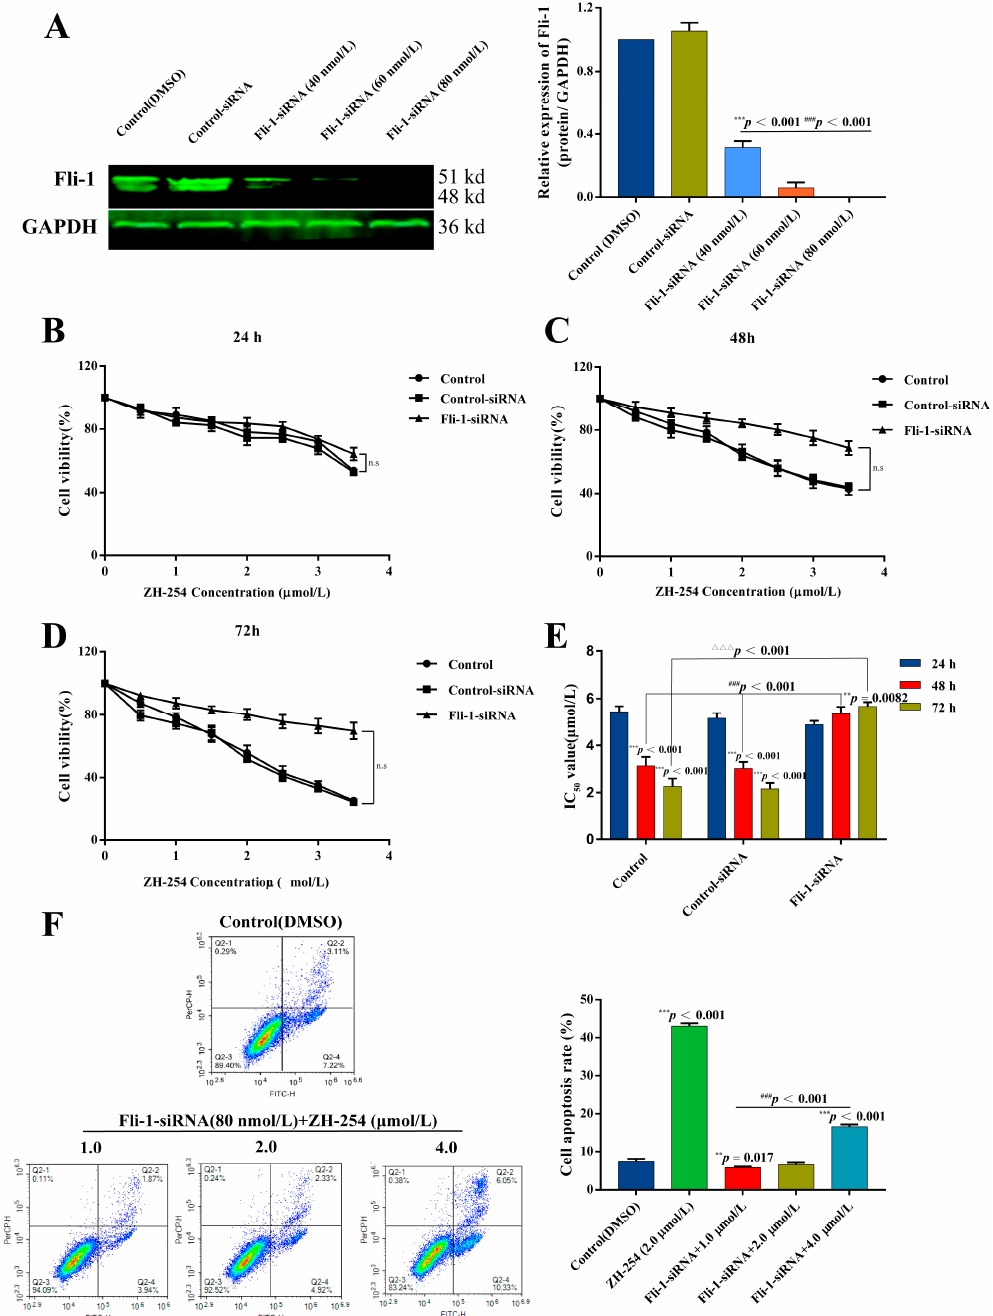
Figure 4. Validation of ZH-254 targeting Fli-1 against HEL cells. ( A ) Western blotting was performed to detect Fli-siRNA to silence the expression of Fli-1 in HEL cells. Statistical analysis of the gray value of the Fli-1 protein band using the Image J software (V1.8.0.112, NIH, Bethesda, MD USA). *** p < 0.001 compared with the control (DMSO) group, ### p < 0.001 compared with the control siRNA group. GAPDH is used as a reference for Fli-1. ( B – D ) Proliferation inhibition curves of HEL cells treated with ZH-254 for 24 h, 48 h and 72 h. ( E ) Half-inhibitory concentration (IC 50 value) of HEL cells treated with ZH-254 was statistically calculated at various periods. ** p < 0.01, *** p < 0.001 compared with the control and control siRNA group at 24 h, ### p < 0.001 compared with the control and control siRNA at 48 h, ∆∆∆ p < 0.001 compared with the control and control siRNA at 72 h. ( F ) Flow cytometry was performed to detect apoptosis in ZH-254-treated HEL cells. *** p < 0.001 compared with the control siRNA group, ### p < 0.01 compared with ZH-254.